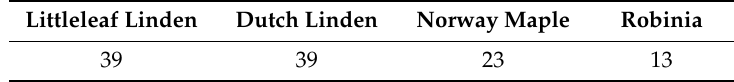
Table 5. Training sample size of tree species classification by MLS data.